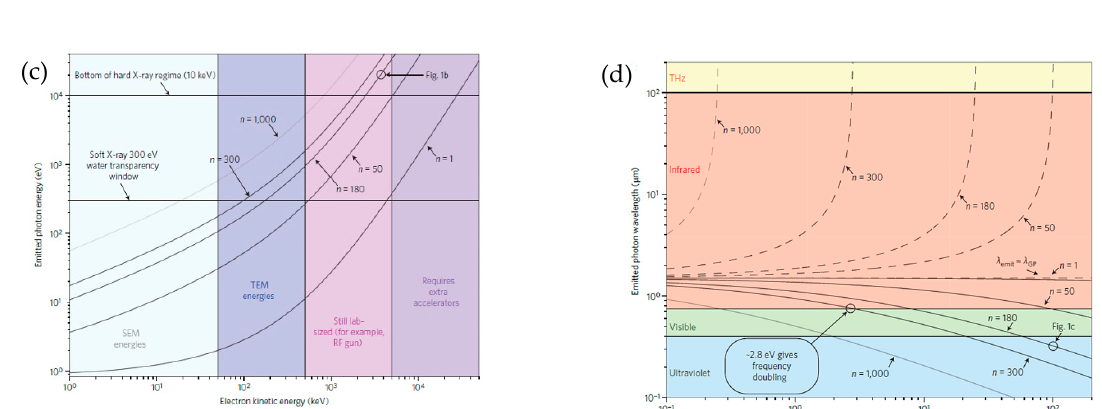
and defines the wiggling red arrows in the